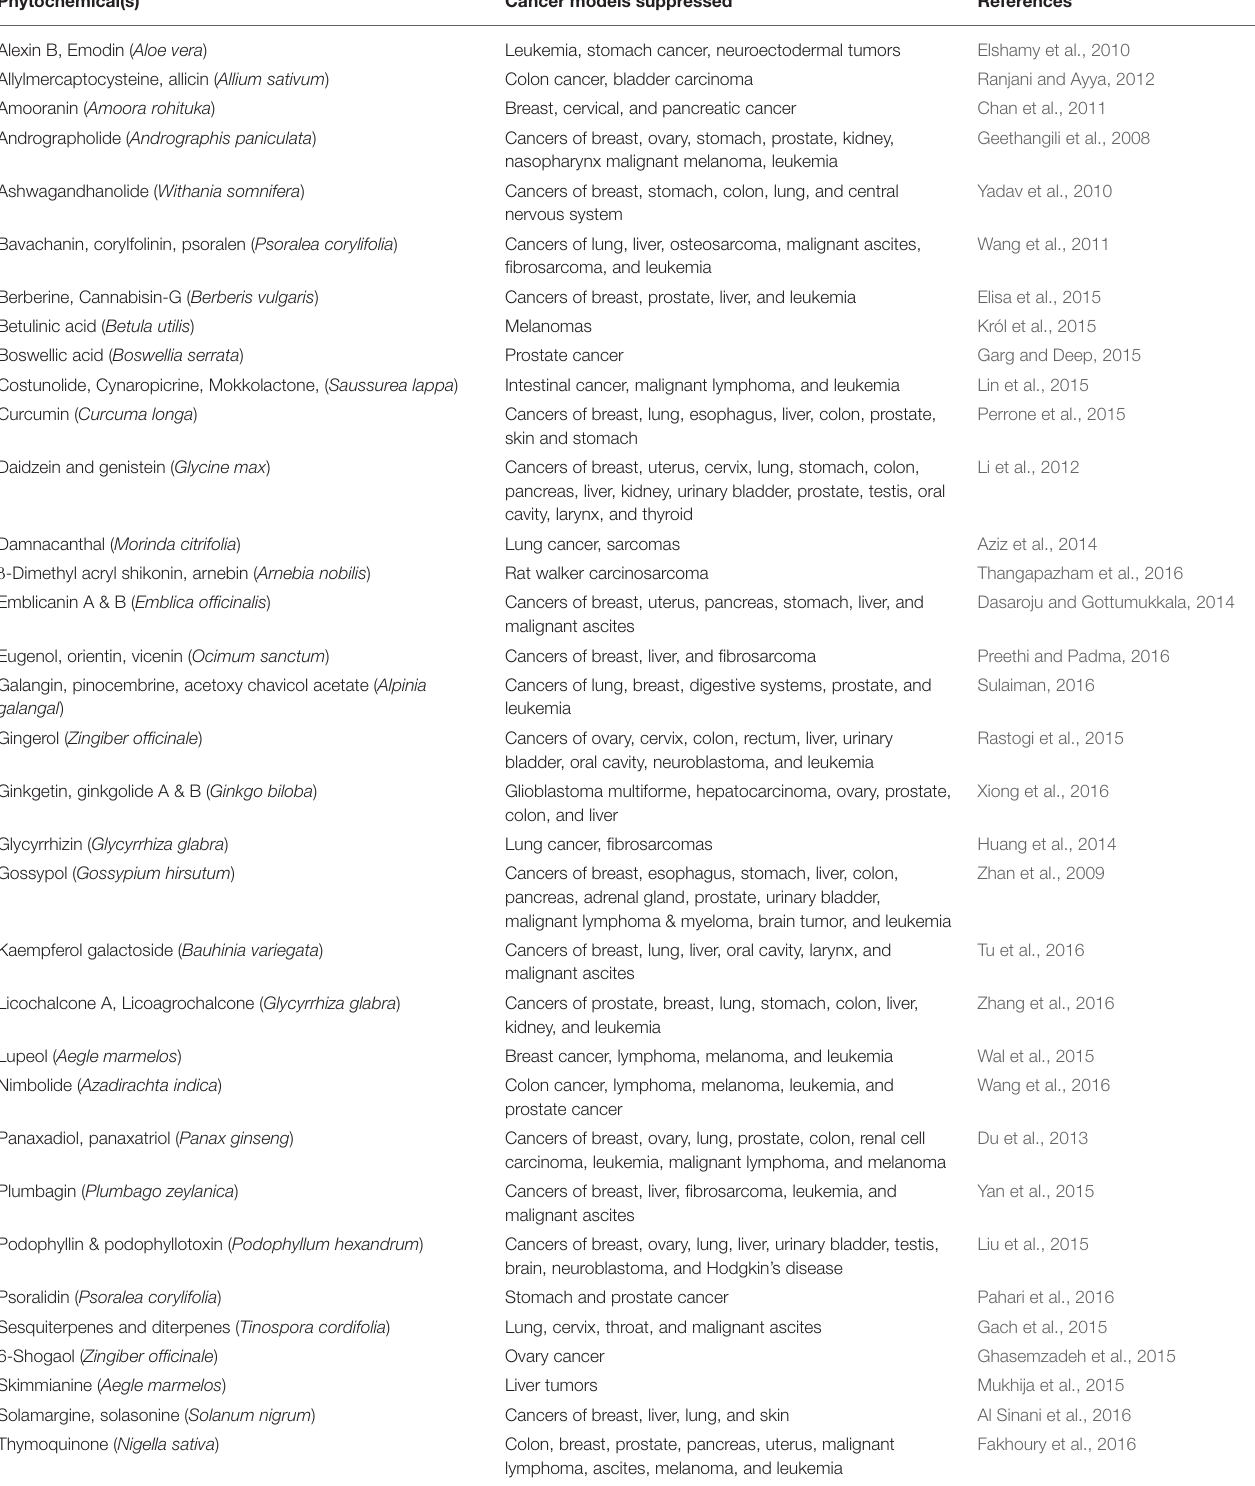
TABLE 3 | Phytochemicals which demonstrated effective tumor killing in various cancer